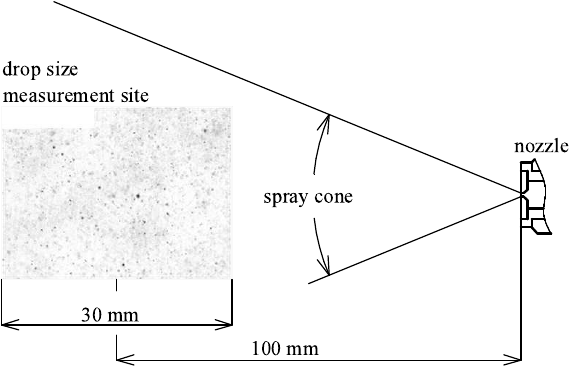
Figure 3. The spray pattern without non-spherical objects, required to perform measurements with Malvern Spraytec device. Image taken for Y-jet nozzle at GLR = 2.5% (liq. 2) with OLYMPUS i-speed2